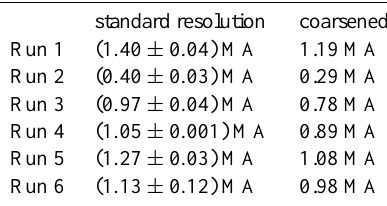
Table 2. Current closing through one